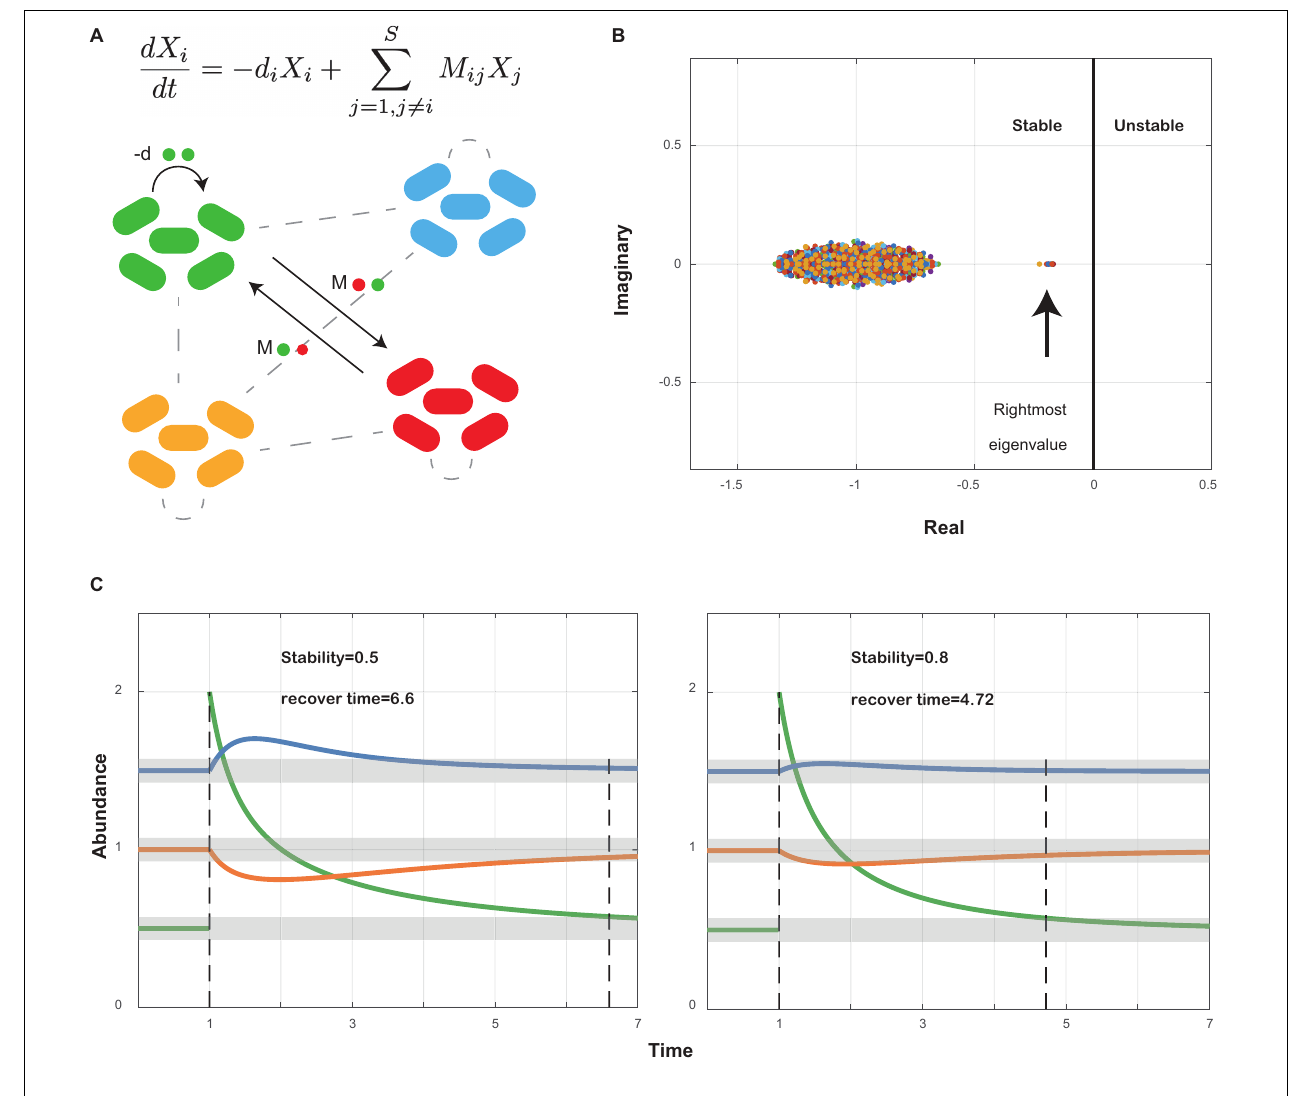
FIGURE 1 | Local stability theory. (A) A schematic diagram shows a small community with bacterial species interacting within themselves ( − d ) and with other species (